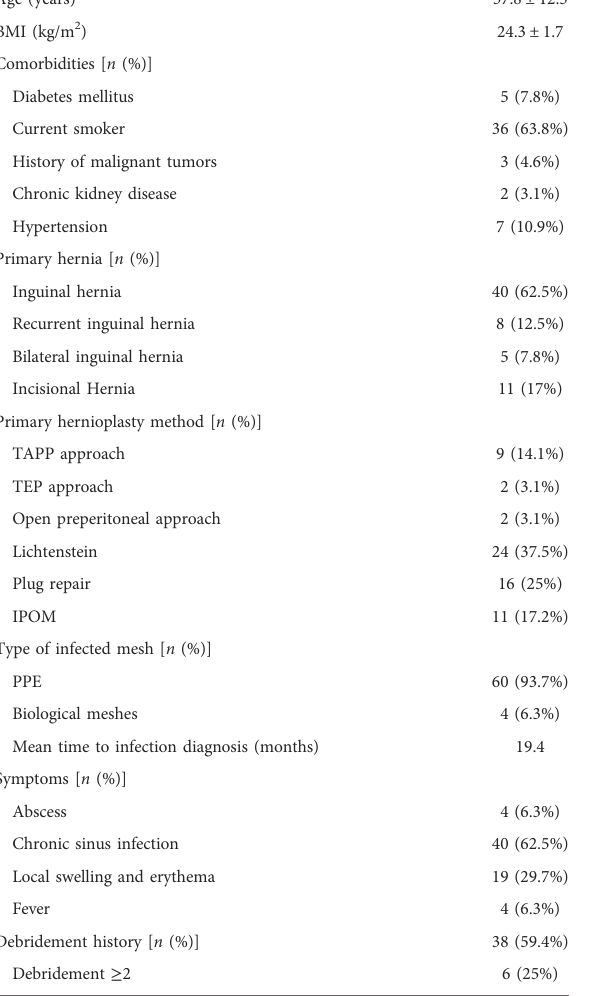
TABLE 3 Patient evaluation and